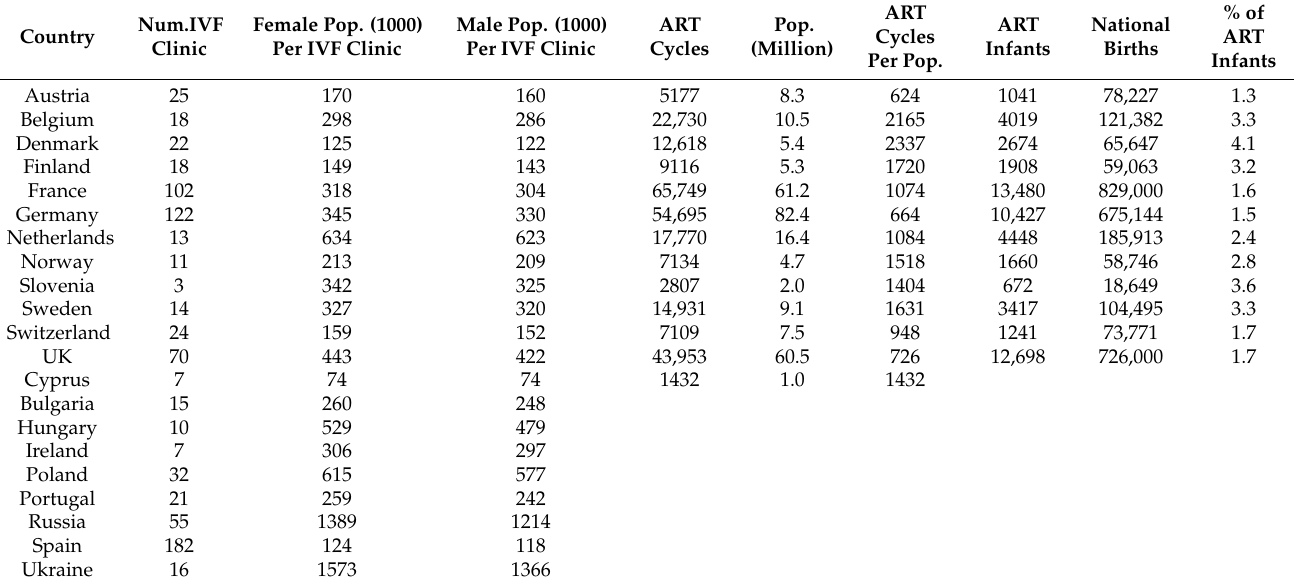
Table 3. Number of IVF clinics, ART cycles, and ART births by